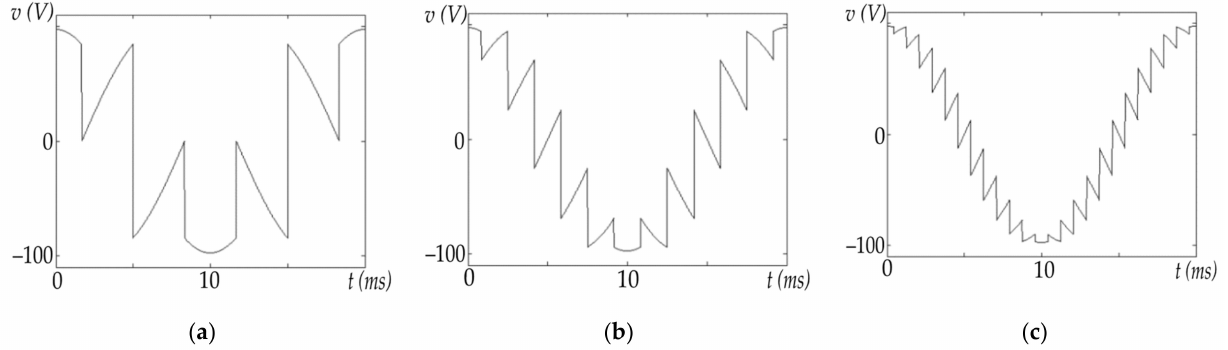
Figure 5. Output voltage as function of input phases for the same control procedure: ( a ) three-phase, ( b ) six-phase, and ( c ) 12-phase